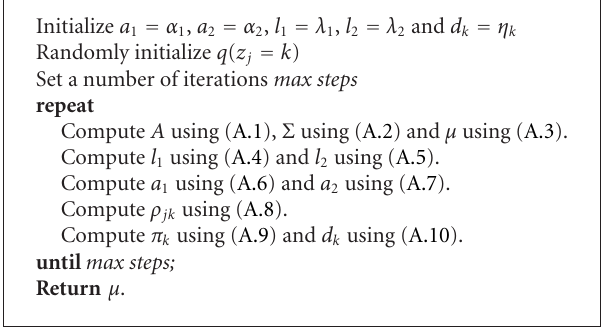
Algorithm 1: VB-MCBR algorithm.